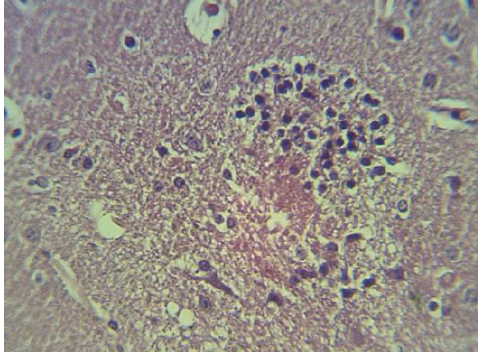
Figure, 3: Histopathological section in the brain of animal treated with chitosan at 30 days shows gliosis in the brain (H&E 40X). Histopathological changes of infected animals with Cryptococcus neoformans died during 2 week:All animals were died during the first week post-infection.The main lesions in kidney characterized by congestion of